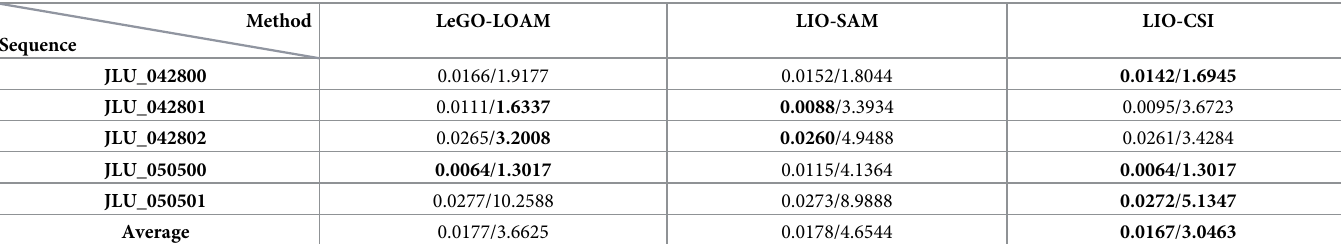
Table 6. Relative pose error on JLU campus dataset.